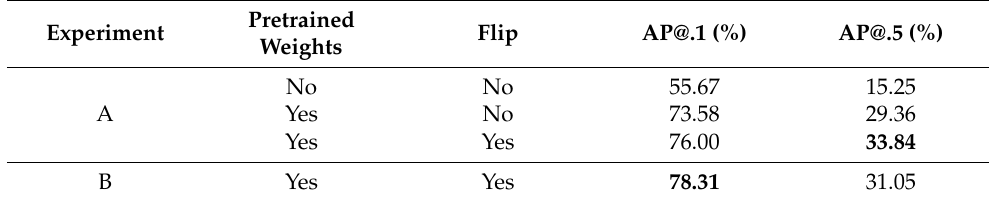
Table 3. AP scores on the test set for both experiment A (Section 3.2) and experiment B (Section 3.3).